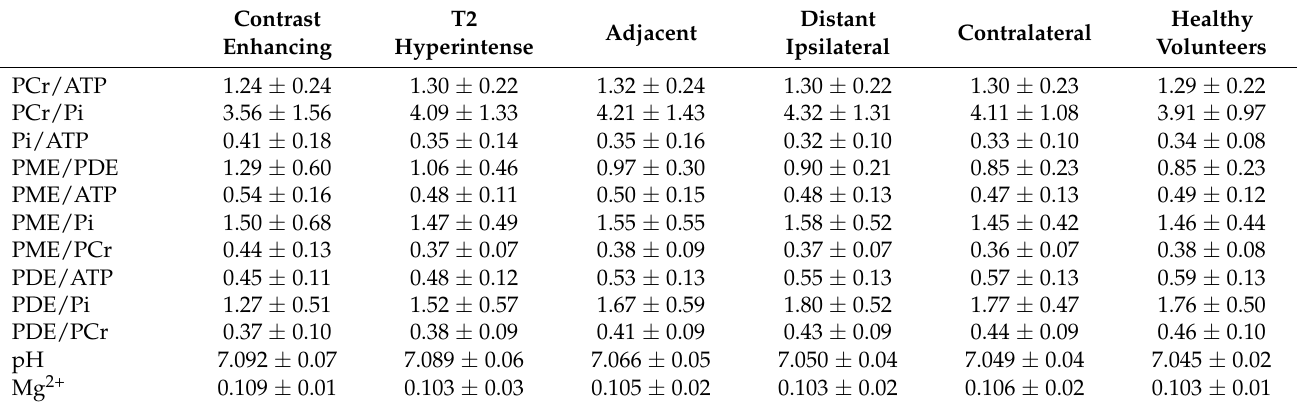
Table 1. Mean values of standard deviations of metabolite ratios and pH and Mg 2+ values in